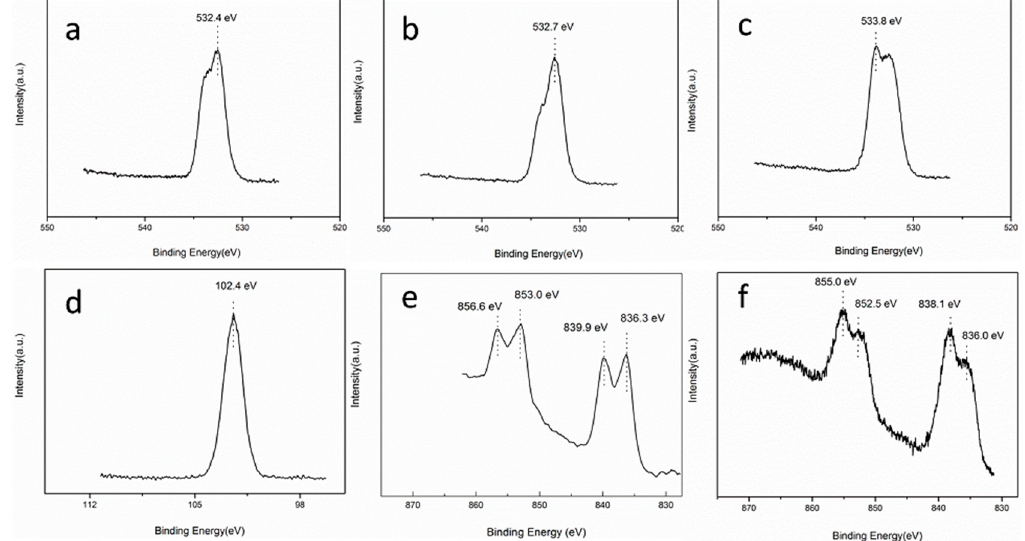
Figure 4. XPS narrow-spectra of ( a ) O 1s of PBO-Pre, ( b ) O 1s of PBO-APTES, ( c ) O 1s of PBO-La, ( d ) Si 2p of PBO-APTES, ( e ) La 3d of LaCl 3 , and ( f ) La 3d of PBO-La.